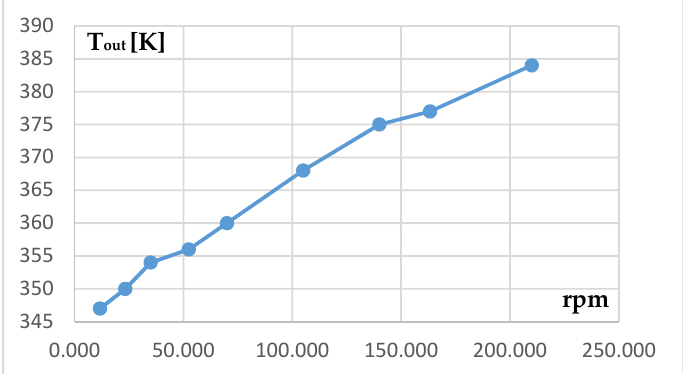
Figure 21. Compressor outlet temperature in function of the EM rpm.